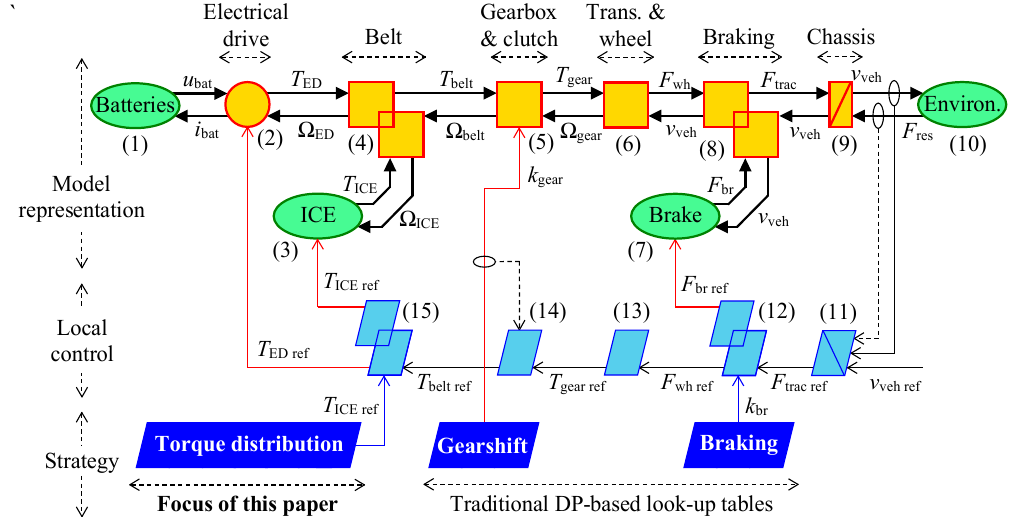
4 of 20 Table 1. Equations for modeling of the studied system. (cid:4688)𝑢 bat = 𝑢 bat OC (cid:4666)𝑆𝑜𝐶 bat (cid:4667) − 𝑟 bat (cid:4666)𝑆𝑜𝐶 bat (cid:4667)𝑖 bat 𝑆𝑜𝐶 bat = 𝑆𝑜𝐶 bat init −